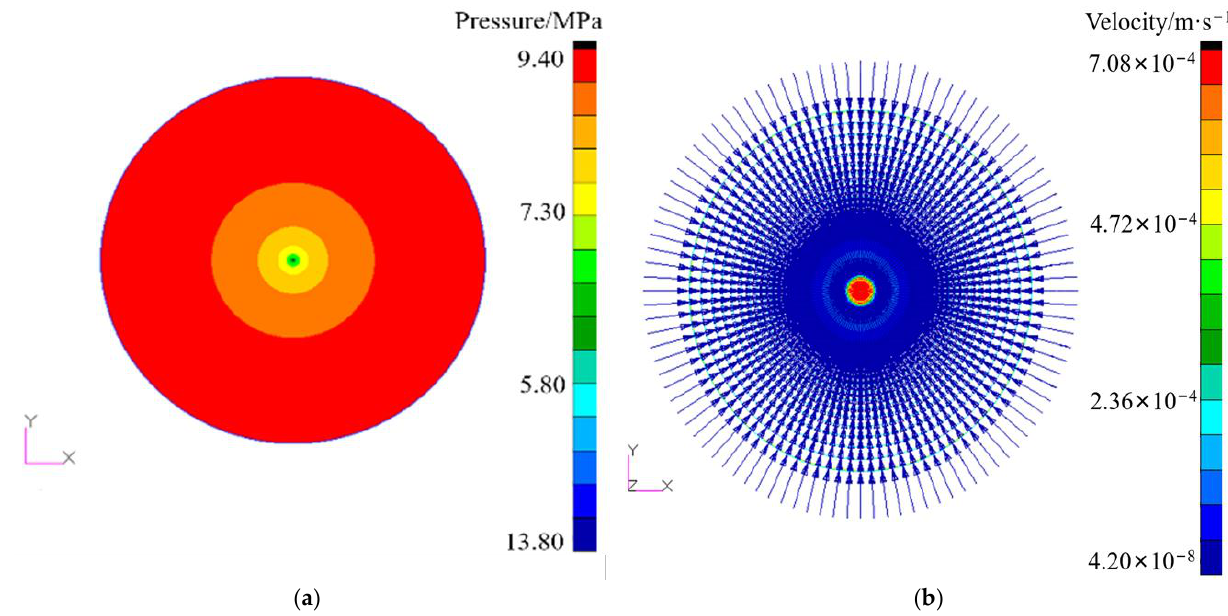
Figure 1. ( a ) Pressure distribution at t = 6.5 h; ( b ) Velocity distribution at t = 6.5 h.